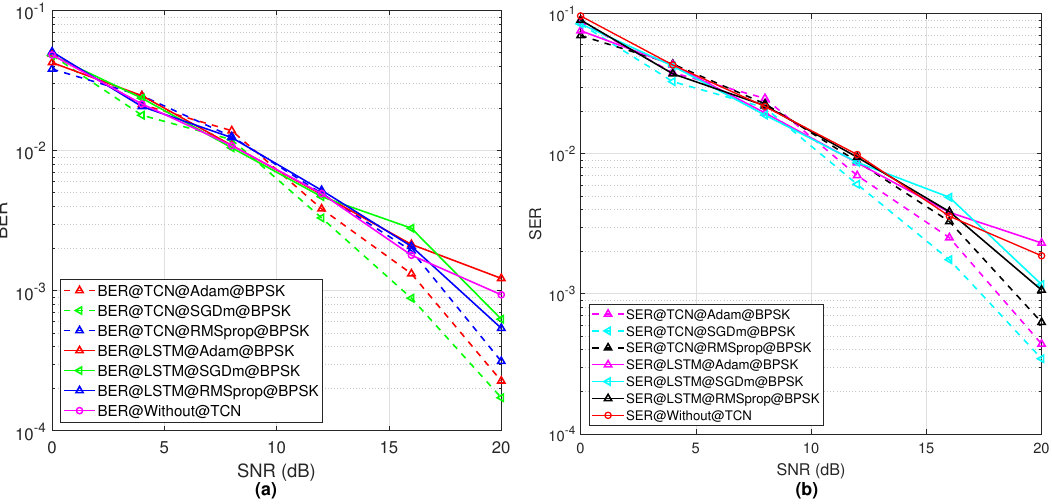
Figure 7. ( a ) The BER results for different optimizers with respect to SNR values for the BPSK modulation, ( b ) SER performance with respect to SNR values for the BPSK modulation scheme for different optimizers.